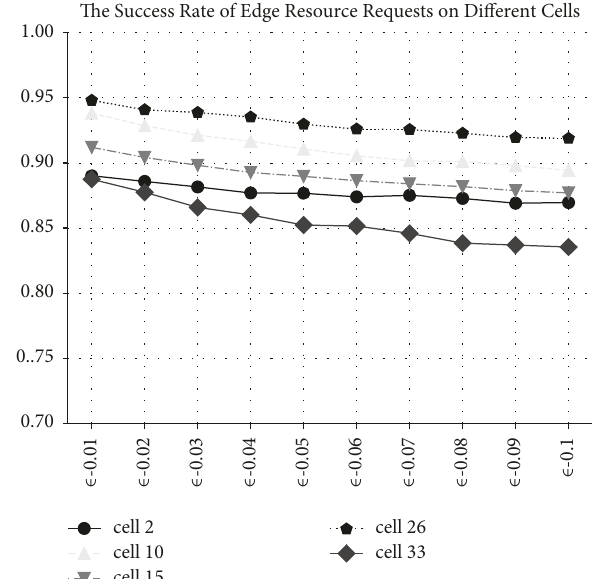
Figure 8: The actual success rate of edge resource requests in different periods.